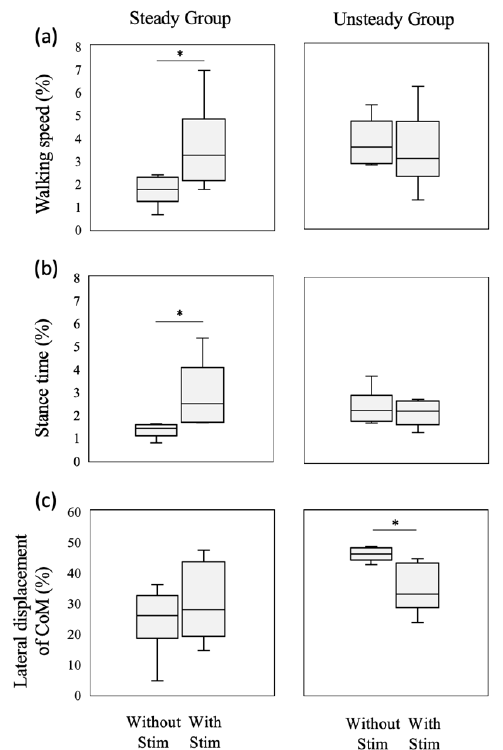
Figure 4. Box plots of CV for ( a ) walking speed, ( b ) stance time, and ( c ) CoM movement in the lateral direction with and without vibrotactile stimulation for the steady ( n = 6) and unsteady ( n = 6) groups. The box indicates the interquartile range. The horizontal and vertical lines indicate the median and the range of the maximum and minimum values, respectively. * indicates significant di ff erences between values obtained with and without stimulation at p <